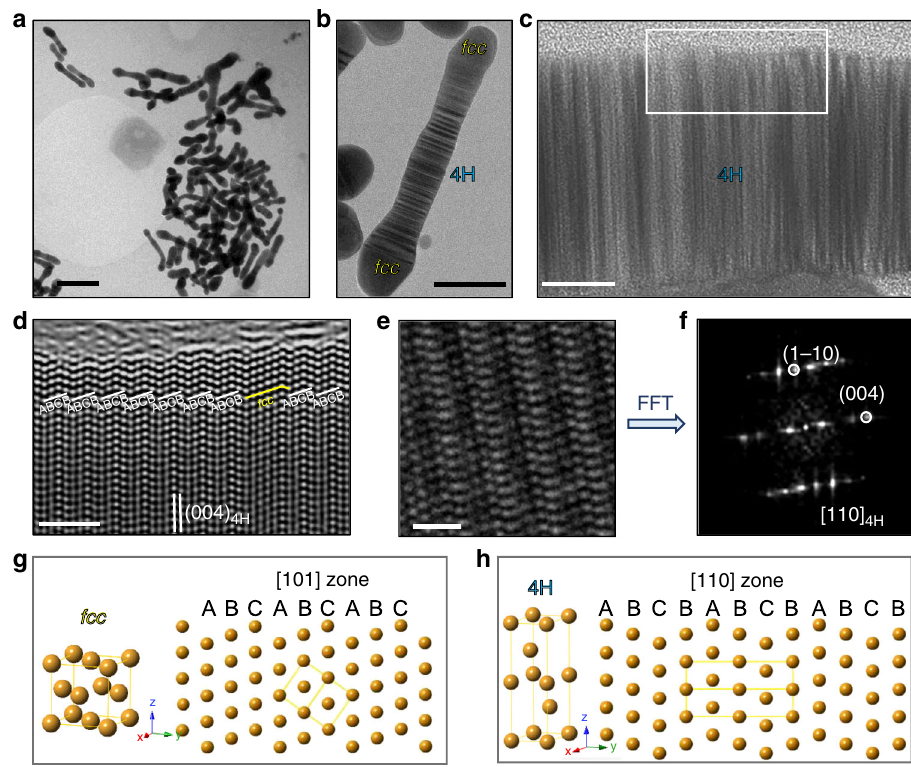
Fig. 1 Microstructure of the Au nanorods. a Overall TEM image of as-synthesized Au nanorods; b larger magni fi cation TEM of gold nanorod showing stacking fault contrast in the 4H phase region in the middle; c HRTEM showing the stacking fault contrast in the 4H phase; d HRTEM at selected area in the white rectangle region in c showing ABCB stacking order in 4H phase in conjunction with fcc twins; e HRTEM image at other region also showing 4H repeating order and its FFT in [110] 4H zone in f ; comparison of the atomic model of fcc Au structure ( g ) and 4H phase ( h ). The scale bar in panel a – e is 200 nm, 50 nm, 5 nm, 2 nm, 1 nm,